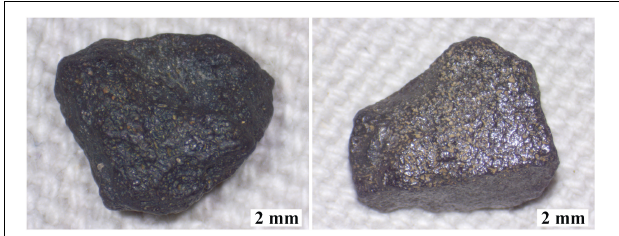
FIGURE 1 | Stereomicroscope images of carbonado nodules used in this study (sample A, left ; and sample B, right